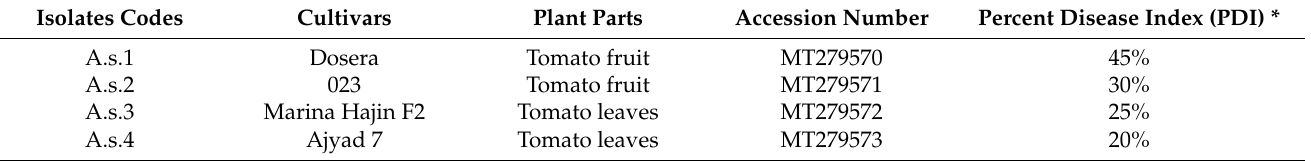
Table 2. Origin, percent disease index and accession numbers of four isolates of Alternaria solani used in this study. Isolates